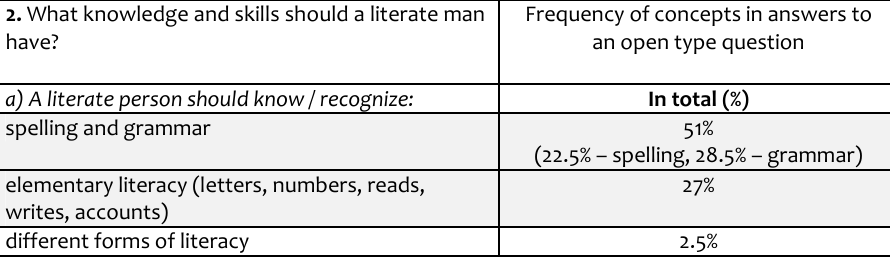
Table 3. Profiling the competence of a written man from the pupil's